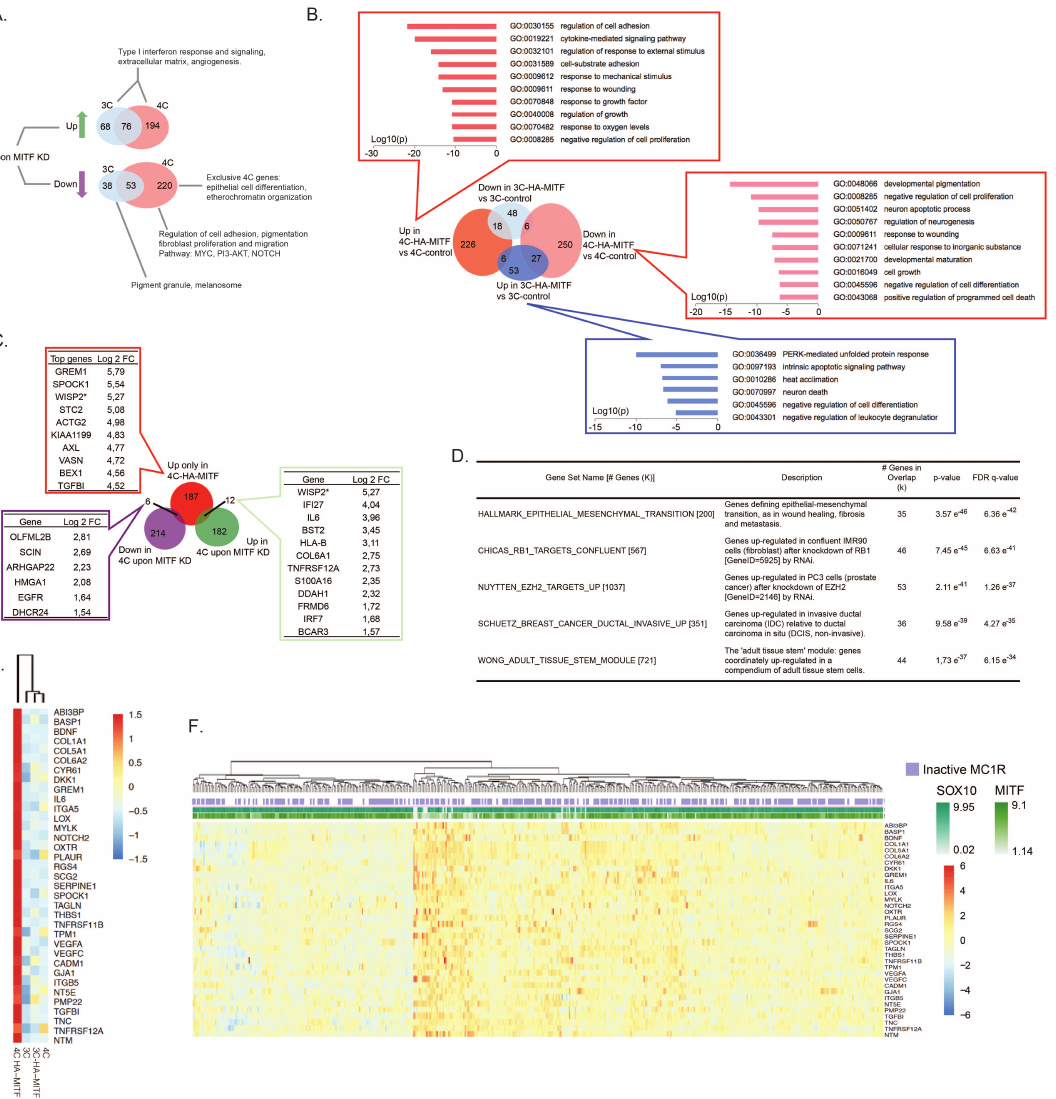
Figure 2. HA-MITF directs specific transcription leading to melanocyte transformation. ( A ) Differentially expressed genes (up and down regulated) upon knockdown of MITF-M in parental Hermes 3C and Hermes 4C cells. ( B ) Di ff erentially expressed genes upon HA-MITF transduction in 3C-HA-MITF and 4C-HA-MITF cells compared to control transduced 3C and 4C cells. The boxes also show top enriched biological processes ( p < 0.00001) according to Gene Ontology analysis. ( C ) Identification of MITF-M target genes important for Hermes 4C transformation based on overlap of genes that were down and up regulated upon MITF-M knockdown in parental Hermes 4C cells (all genes are listed in the speech bubbles along with the Log 2 fold change in 4C-HA-MITF vs. 4C control) with genes that were exclusively upregulated in 4C-HA-MITF vs. 4C control ( n = 205; see also Table S2; top 10 upregulated genes are listed in the related speech bubble). ( D ) Gene set enrichment analysis for genes exclusively upregulated in 4C-HA-MITF cells compared to 4C control cells transduced with control vector, not concomitantly upregulated in 3C-HA-MITF vs. 3C control nor 4C control vs. 3C control ( n = 205; see also Table S2). Clustering analysis of Hermes cells and derivatives transduced with HA-MITF ( E ) and 371 cases of melanoma from The Cancer Genome Atlas (TCGA) ( F ) according to the expression of 35 genes exclusively upregulated in 4C-HA-MITF 200 genes included in the epithelial to mesenchymal transition (EMT) hallmark